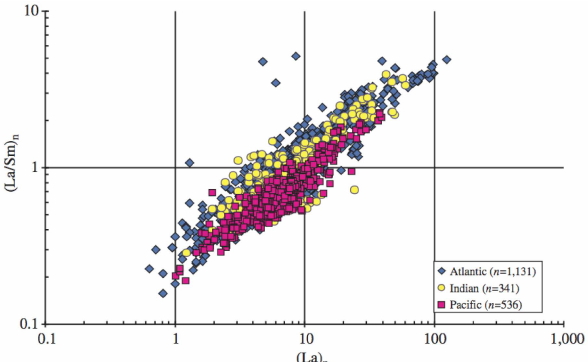
Fig. 20. La/Sm versus La, normalised to primitive-mantle, for MORB from three Ocean basins. Lanthanum concentrations vary by about two orders of magnitude; La/Sm varies by more than one order of magnitude. Data were extracted from PETDB. From Hof- mann (2003). Copyright Elsevier Science. Reprinted with permis-